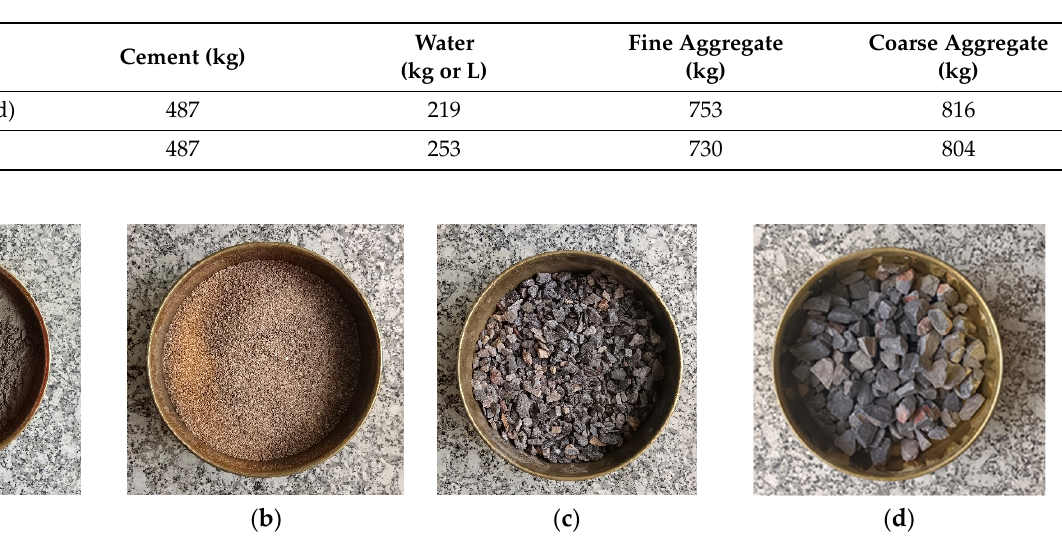
Table 2. Mixture proportion per 1 m 3 .